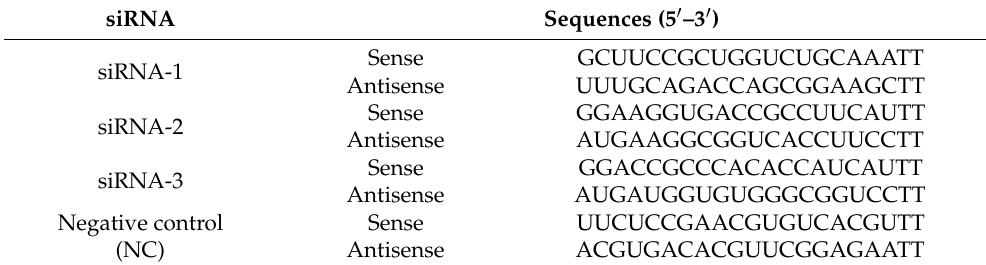
Table 1. siRNA sequences targeting the bovine CLDN6 gene.